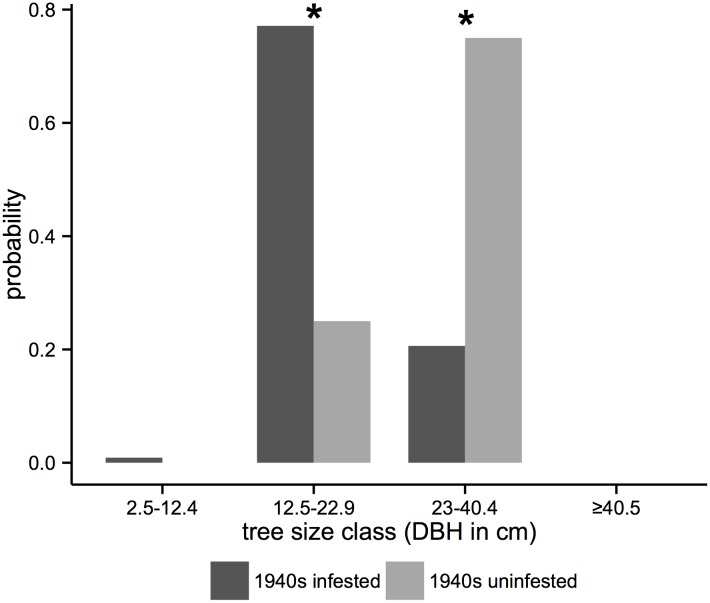
The conditional probability of current dominant tree size given the presence or absence of the 1940s spruce beetle infestation in the Flat Tops study area.Dark gray bars indicate the probability that a 990 x 990 m spruce-fir pixel is infested by spruce beetles; light gray bars indicate the probability a pixel is uninfested. The asterisk symbol (*) above a pair of bars indicates a meaningful difference between conditional probability of uninfested and infested forest.